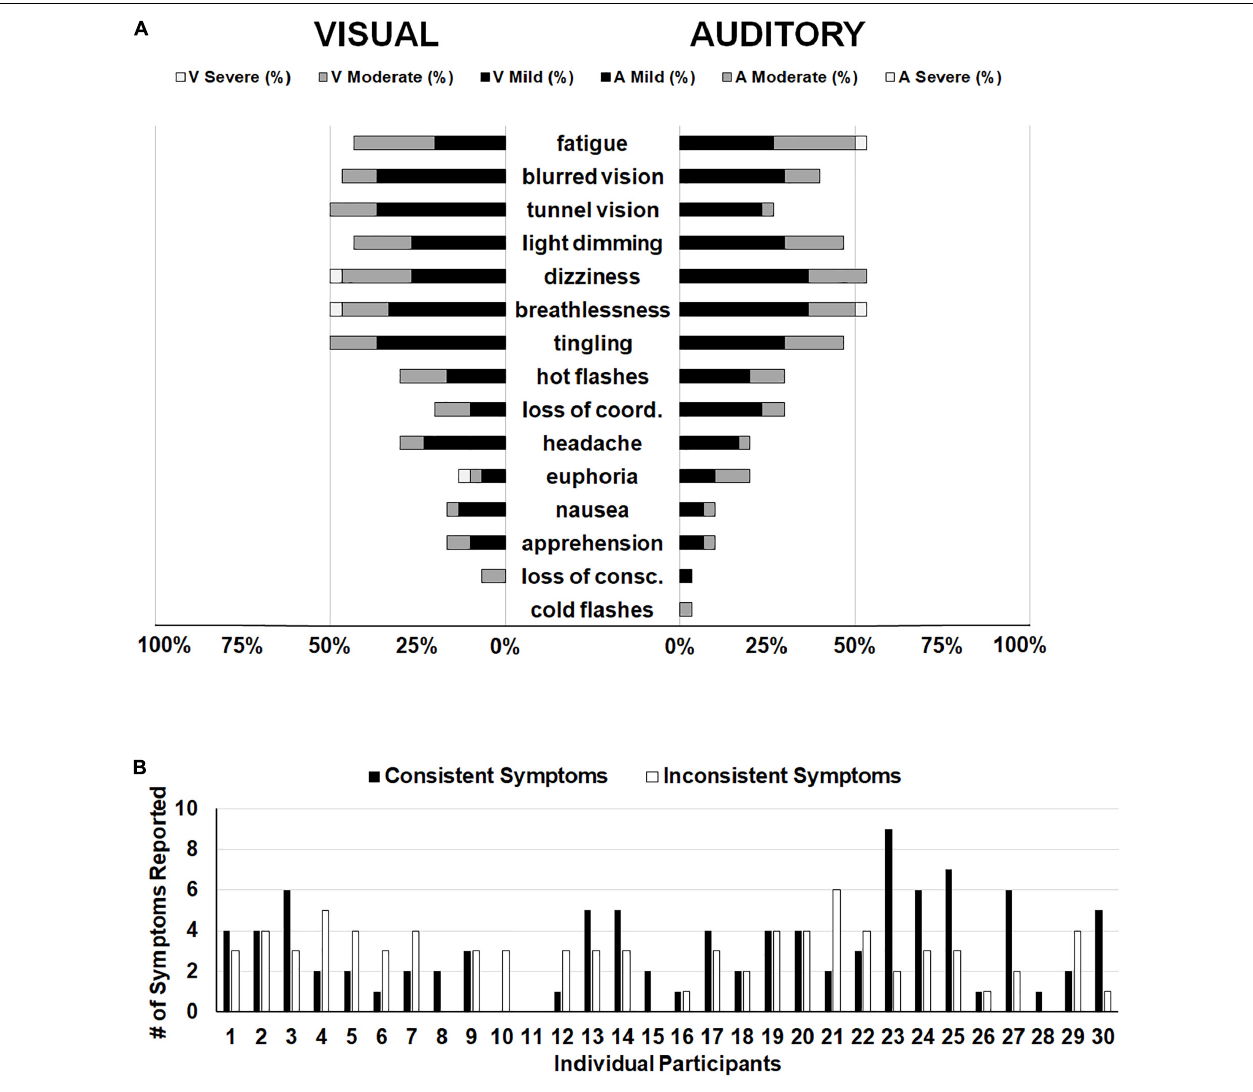
FIGURE 5 | (A) Frequency of reporting for each item on the HSQ. The left side displays symptom reporting for the visual stimuli hypoxia session and the right side displays the auditory stimuli hypoxia session. Bars represent the distribution of severity reported for each symptom (i.e., black for mild, dark gray for moderate, and white for severe). Empty space reaching out to 100% represents the percentage of participants who did not report observing that particular symptom. (B) Individual participant data demonstrating the number of symptoms reported consistently (i.e., both hypoxia sessions; black bars) and the number of symptoms reported inconsistently (i.e., one hypoxia session, but not the other; white